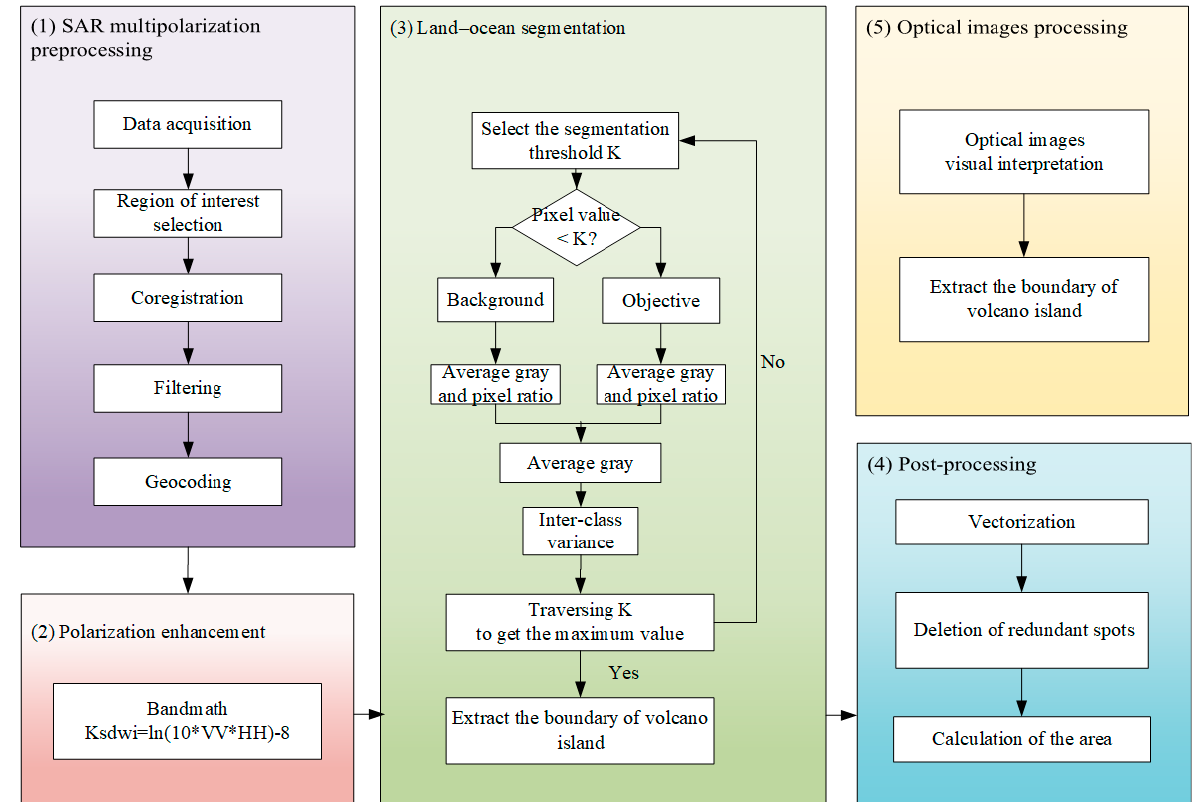
Figure 3. Flowchart of the proposed method.